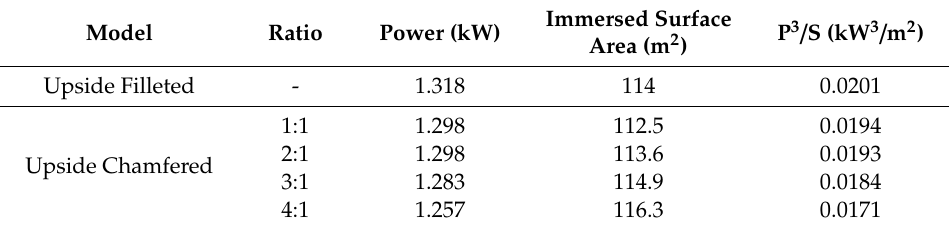
Table 3. The optimized results for upside filleted and chamfered shape.